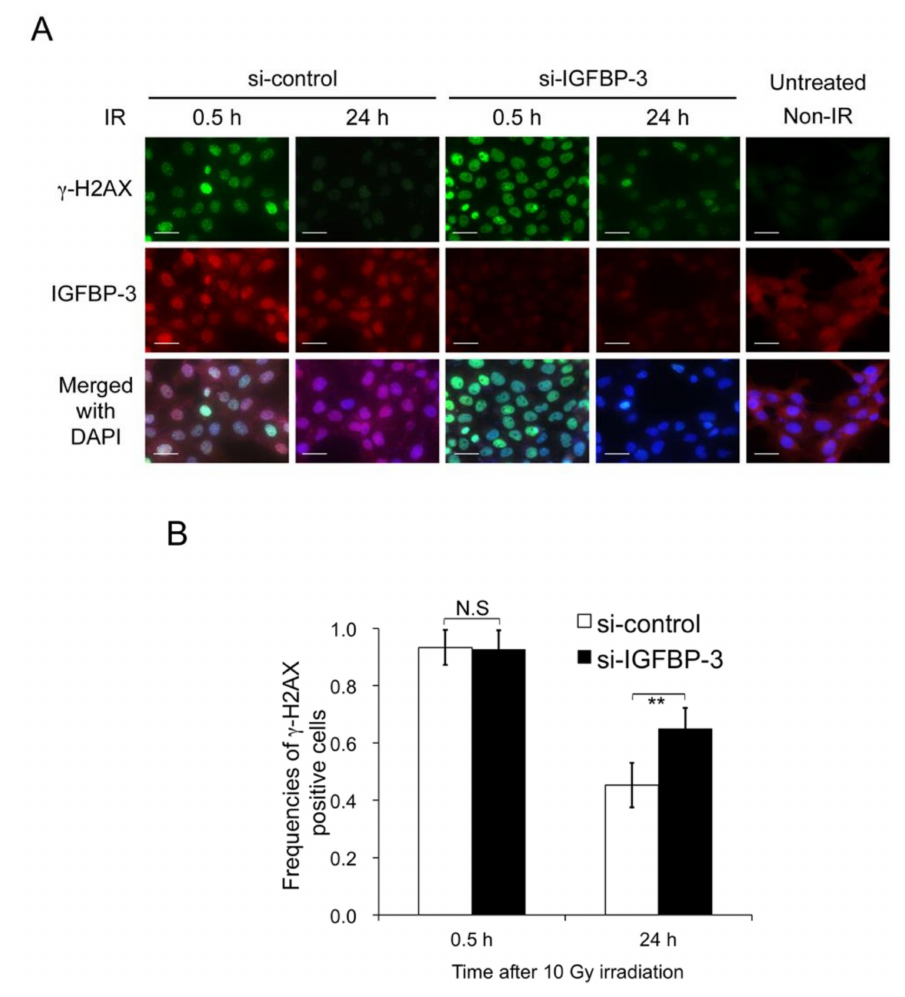
Figure 3. IGFBP-3 helps reduce DNA damage in irradiated OSCC cells. ( A ) Representative immunofluorescence images of γ -H2AX foci and IGFBP-3 in SAS cells after exposure to 10 Gy irradiation (IR) following transfection with control or IGFBP-3-specific siRNA. ( B ) Frequencies of γ -H2AX-positive cells at each time point after irradiation and with or without IGFBP-3 inhibition. The results are shown as the means ± SD of three independent experiments. ** p < 0.01. Scale bar, 50 µ m. 2.5. Functional Role of IGFBP-3 in the DNA Repair of Irradiated OSCC